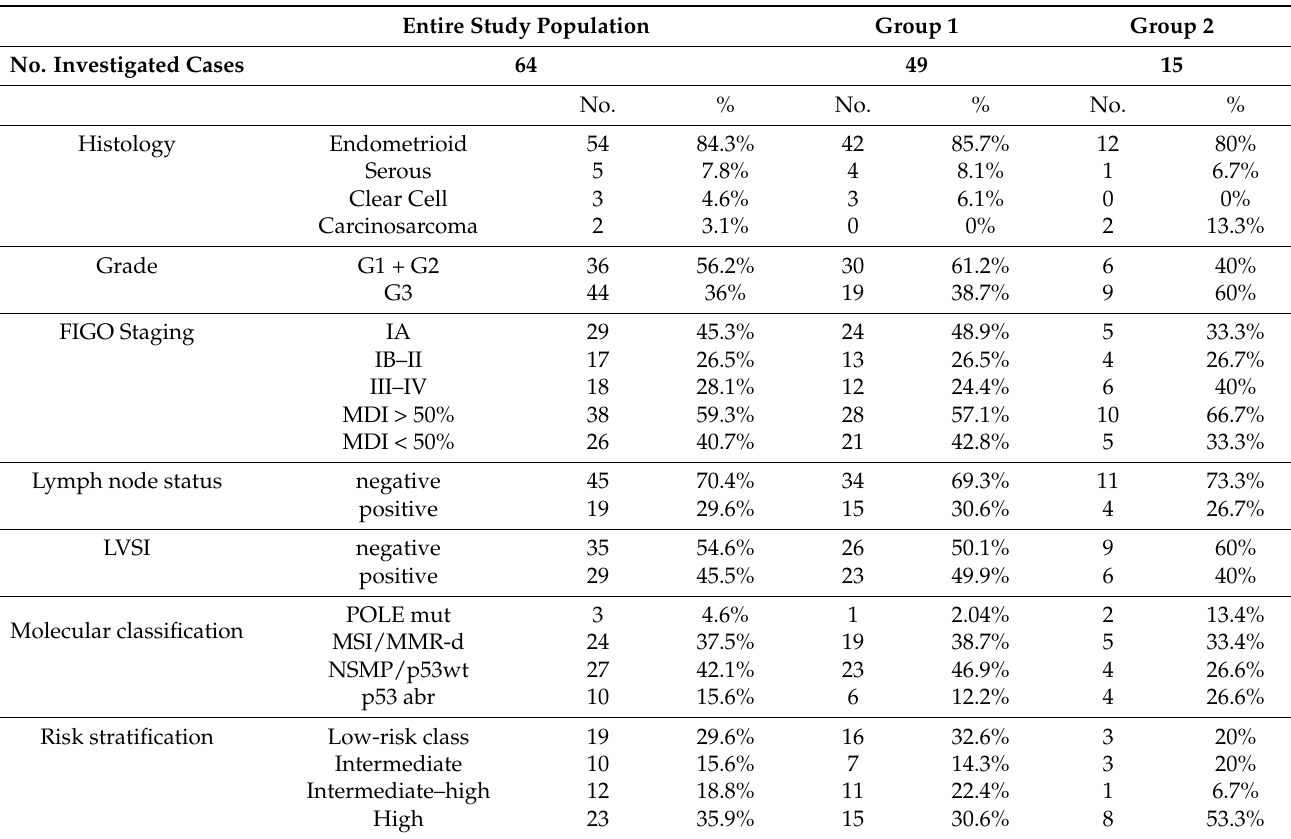
Table 4. Histopathological and molecular data in 70 patients with endometrial carcinoma.